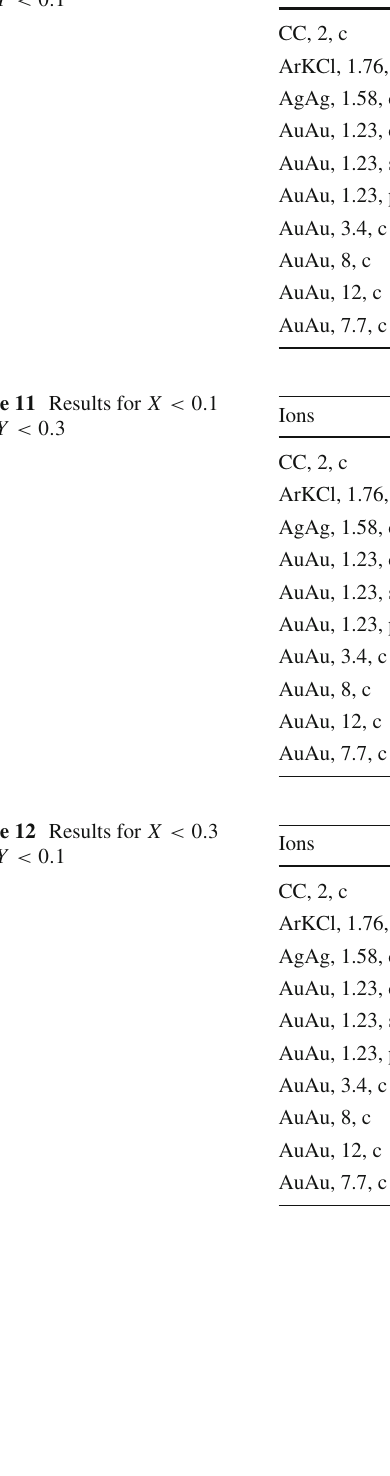
Table 10 Results for X < 0 . 1